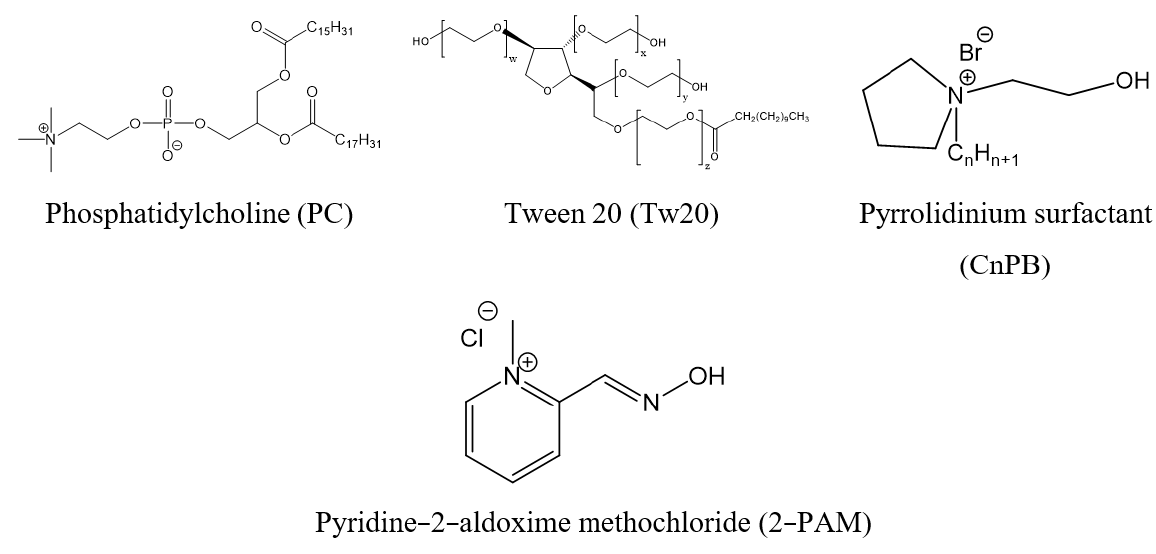
Figure 1. Structural formulas of compounds used.